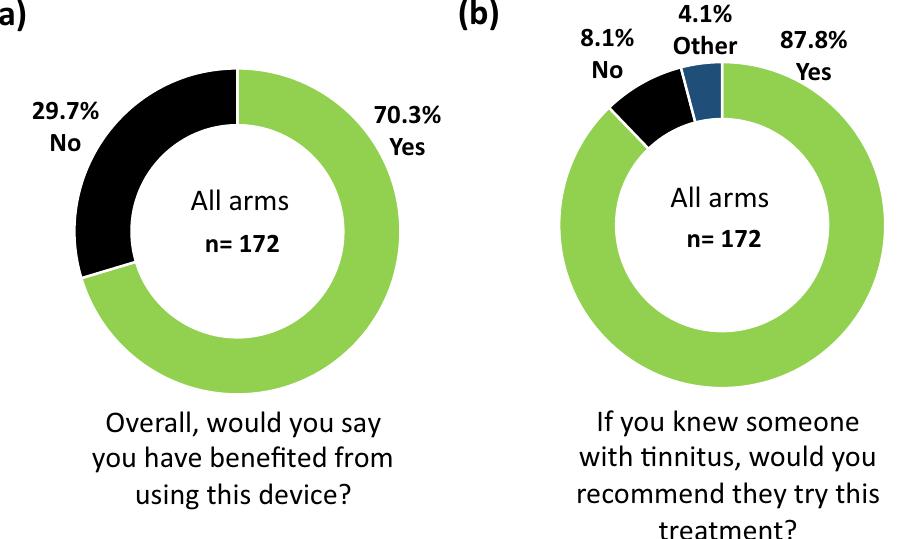
Figure 9. Satisfaction rates in using treatment device. Two questions relating to the participant’s satisfaction ( a ) or acceptability ( b ) of the treatment device were asked at the final visit when the treatment ended, in which the percentage of YES or NO responses are shown. The “other” category refers to cases where the participant could not answer YES or NO or did not feel comfortable in committing to an